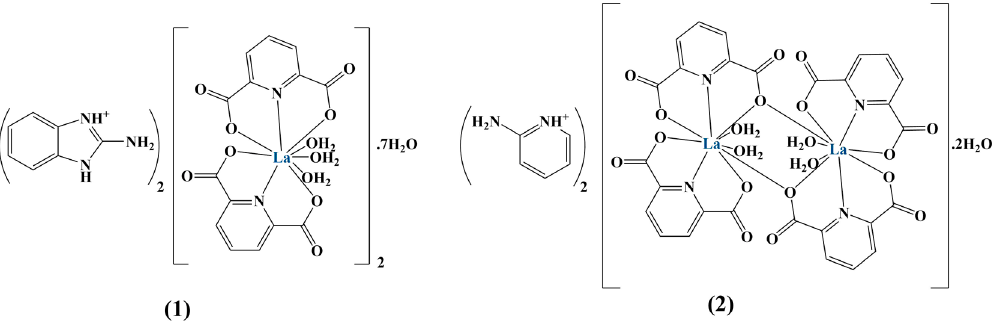
Figure 37. The ligands of the complexes presented in [132].